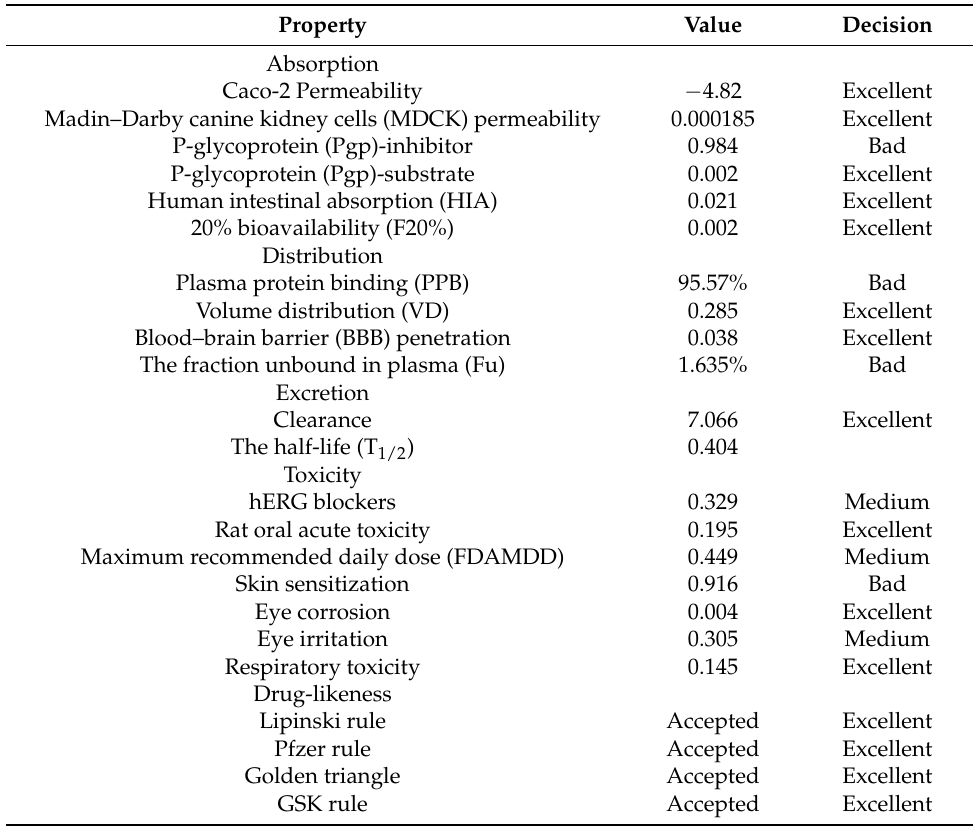
Figure 11. The physicochemical properties of compound I 23 . Table 3. ADMET and drug-likeness properties of compound I 23 through the online prediction tool ADMETlab 2.0.